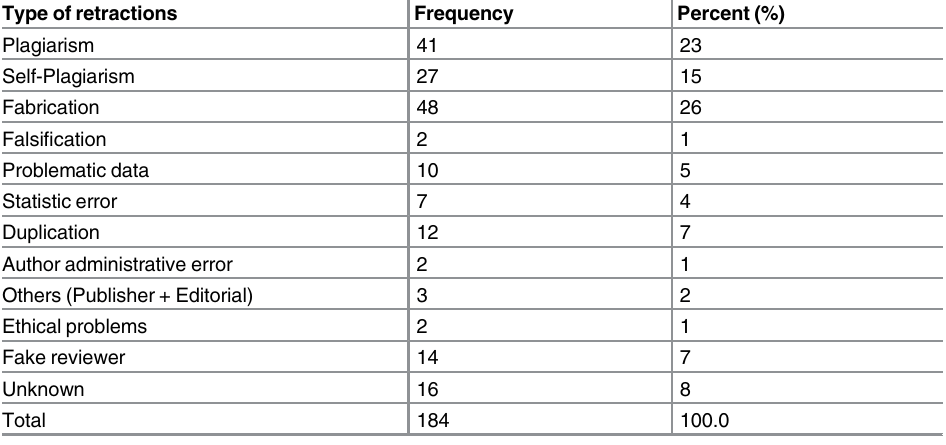
Table 5. Retraction reasons of the papers in MBE from first documented retraction until the end of 2015 *